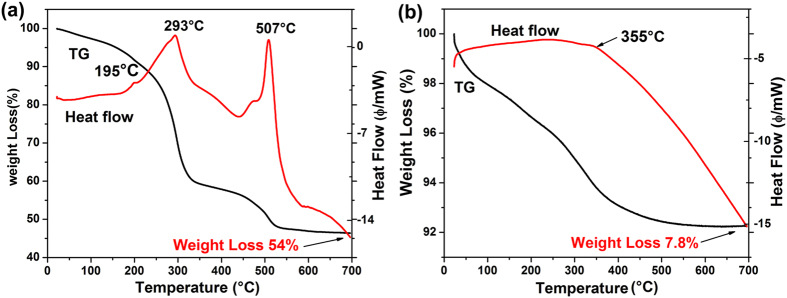
TG-DTA curves of (a) Eu(TTA)3·nH2O and (b) Eu(TTA)3@BN, in the presence of air.